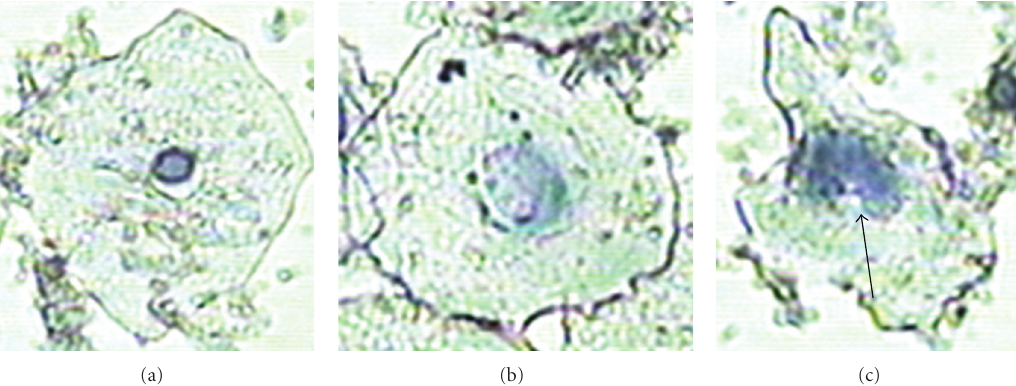
Figure 1: Morphology of cervical epithelial cells. Pap smear cells were obtained from patients and reviewed by a pathologist. From left to right, photos show a normal, LSIL, and HSIL cell. Arrow: the nucleus.